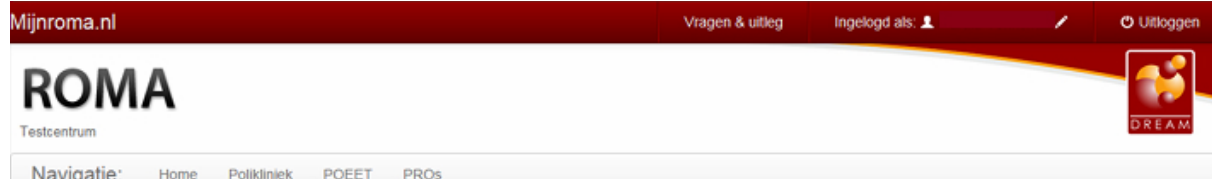
Figure 2. Screenshot of the CAT Fatigue